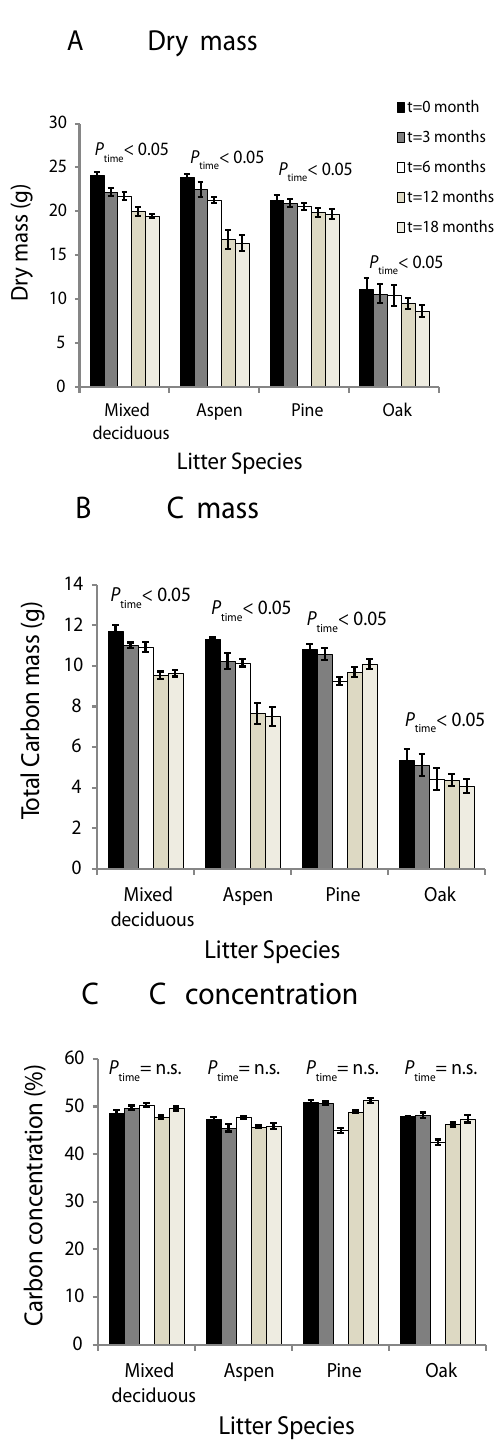
Fig. 1. Development of dry mass, carbon (C) mass, and C con- centrations throughout 18 months of litter decomposition in a con- trolled laboratory study. Bars represent means ± standard devia- tions of five replicate samples. P -values are effects of Time for individual species based on Bonferroni post-hoc analyses (Table